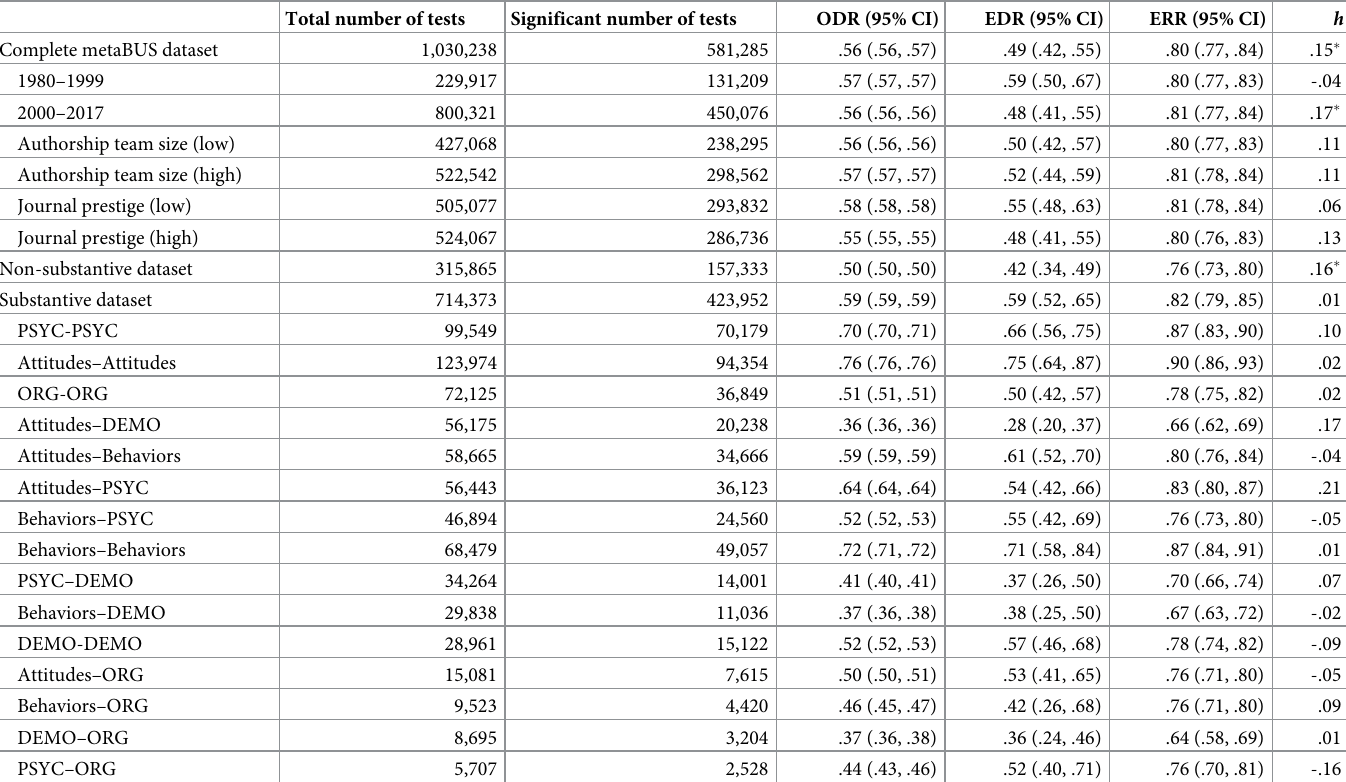
Table 4. P- hacking results according to the z-curve